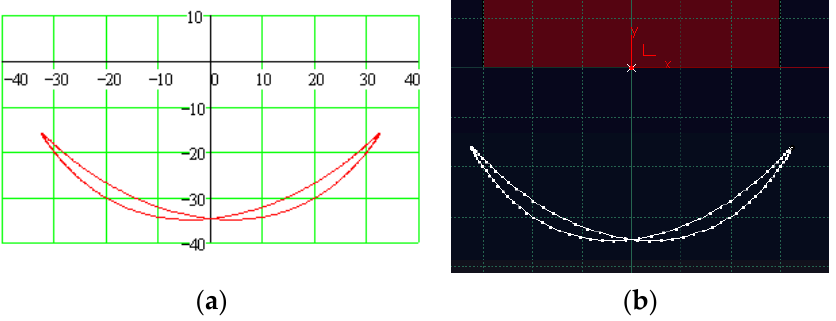
Figure 6. The trajectory of the point O 2 in the frame attached to the driving element: ( a ) analytical solution and ( b ) numerical simulation.